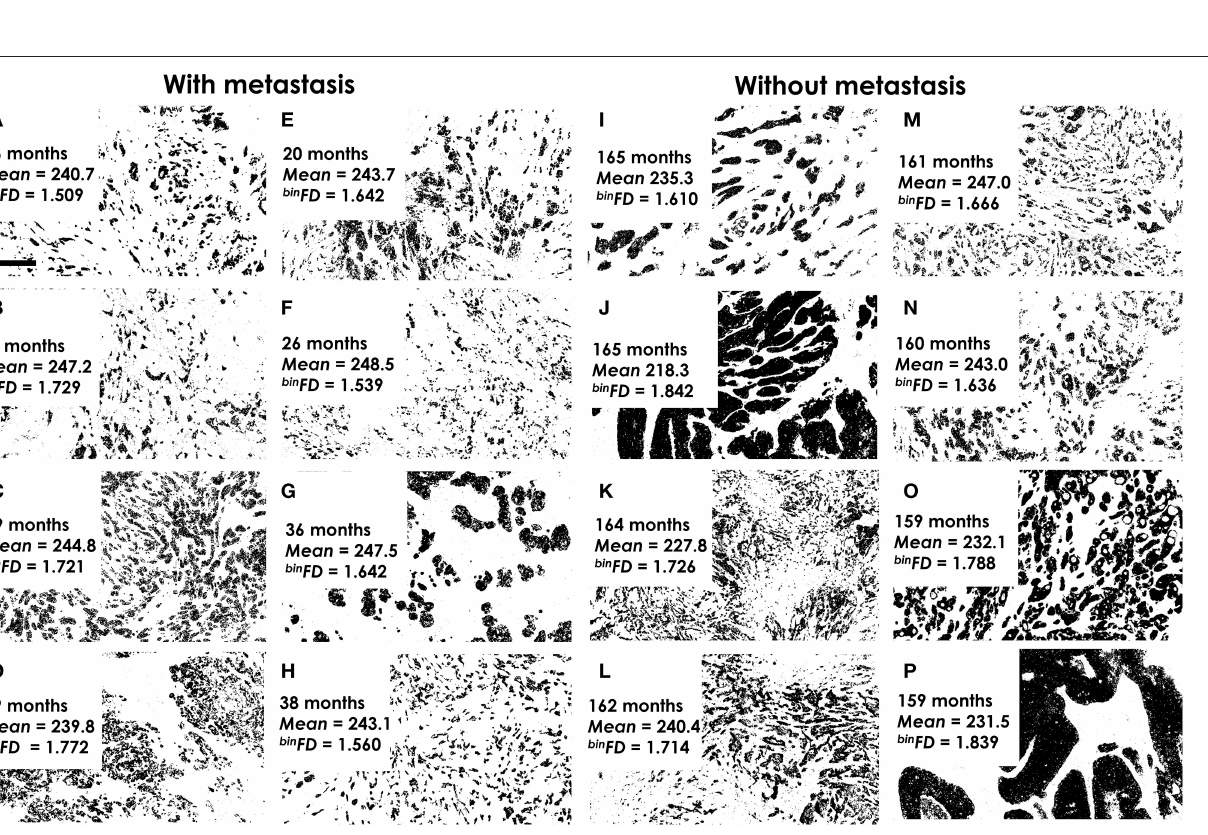
Spearman’s rank correlation coefficients are displayed. * P ≤ 0.05.